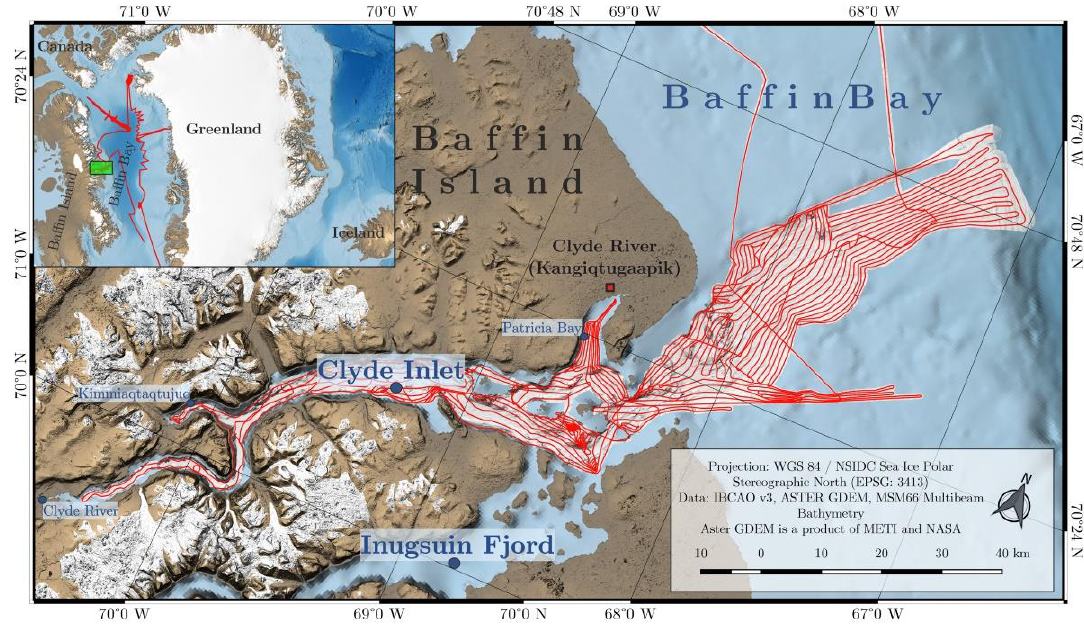
Figure 2. Overview of Clyde Inlet showing track lines (red) of cruise MSM66.